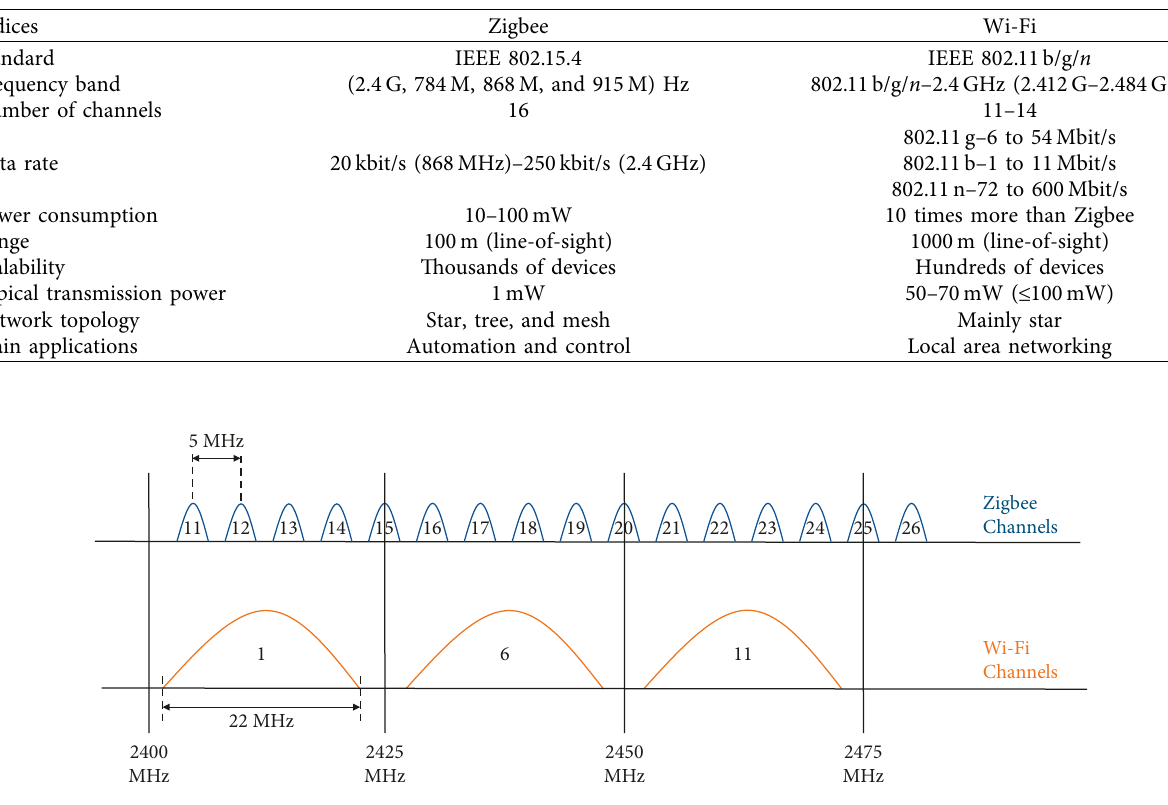
Table 1: Comparisons between Zigbee and